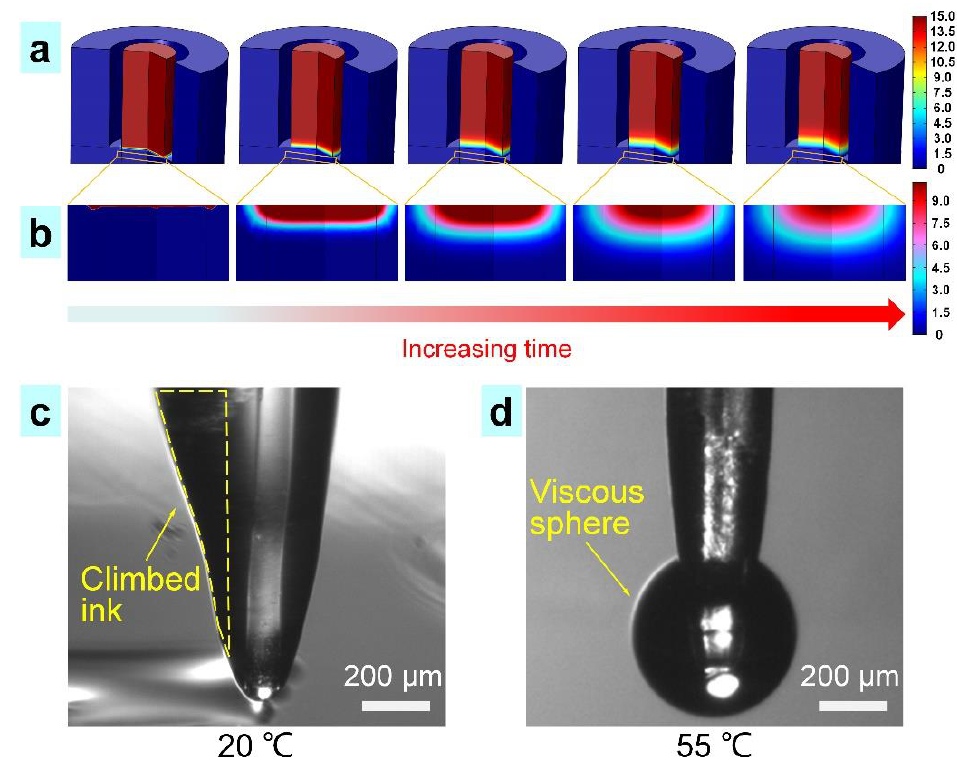
Figure 3. The process of tip-viscid. ( a ) The simulation results of the solvent content at 55 °C (unit, mol L − 1 ); ( b ) The solvent content in the jet; ( c ) The ink climbed along the needle without a thermal effect (at 20 °C); ( d ) The ink transformed into a high viscous sphere with a thermal field (at 55 °C), suspending at the needle tip.